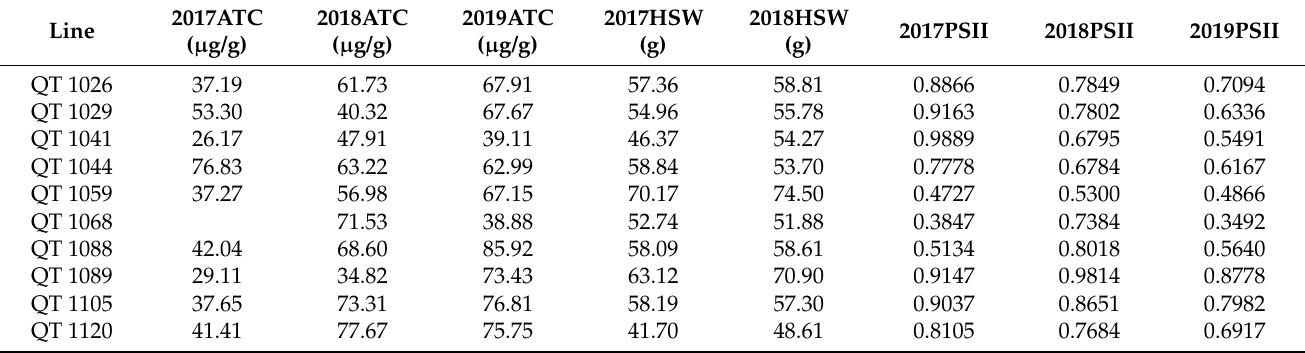
Table 3. Detailed ATC, HSW and PSII of 15 accessions and parents across different